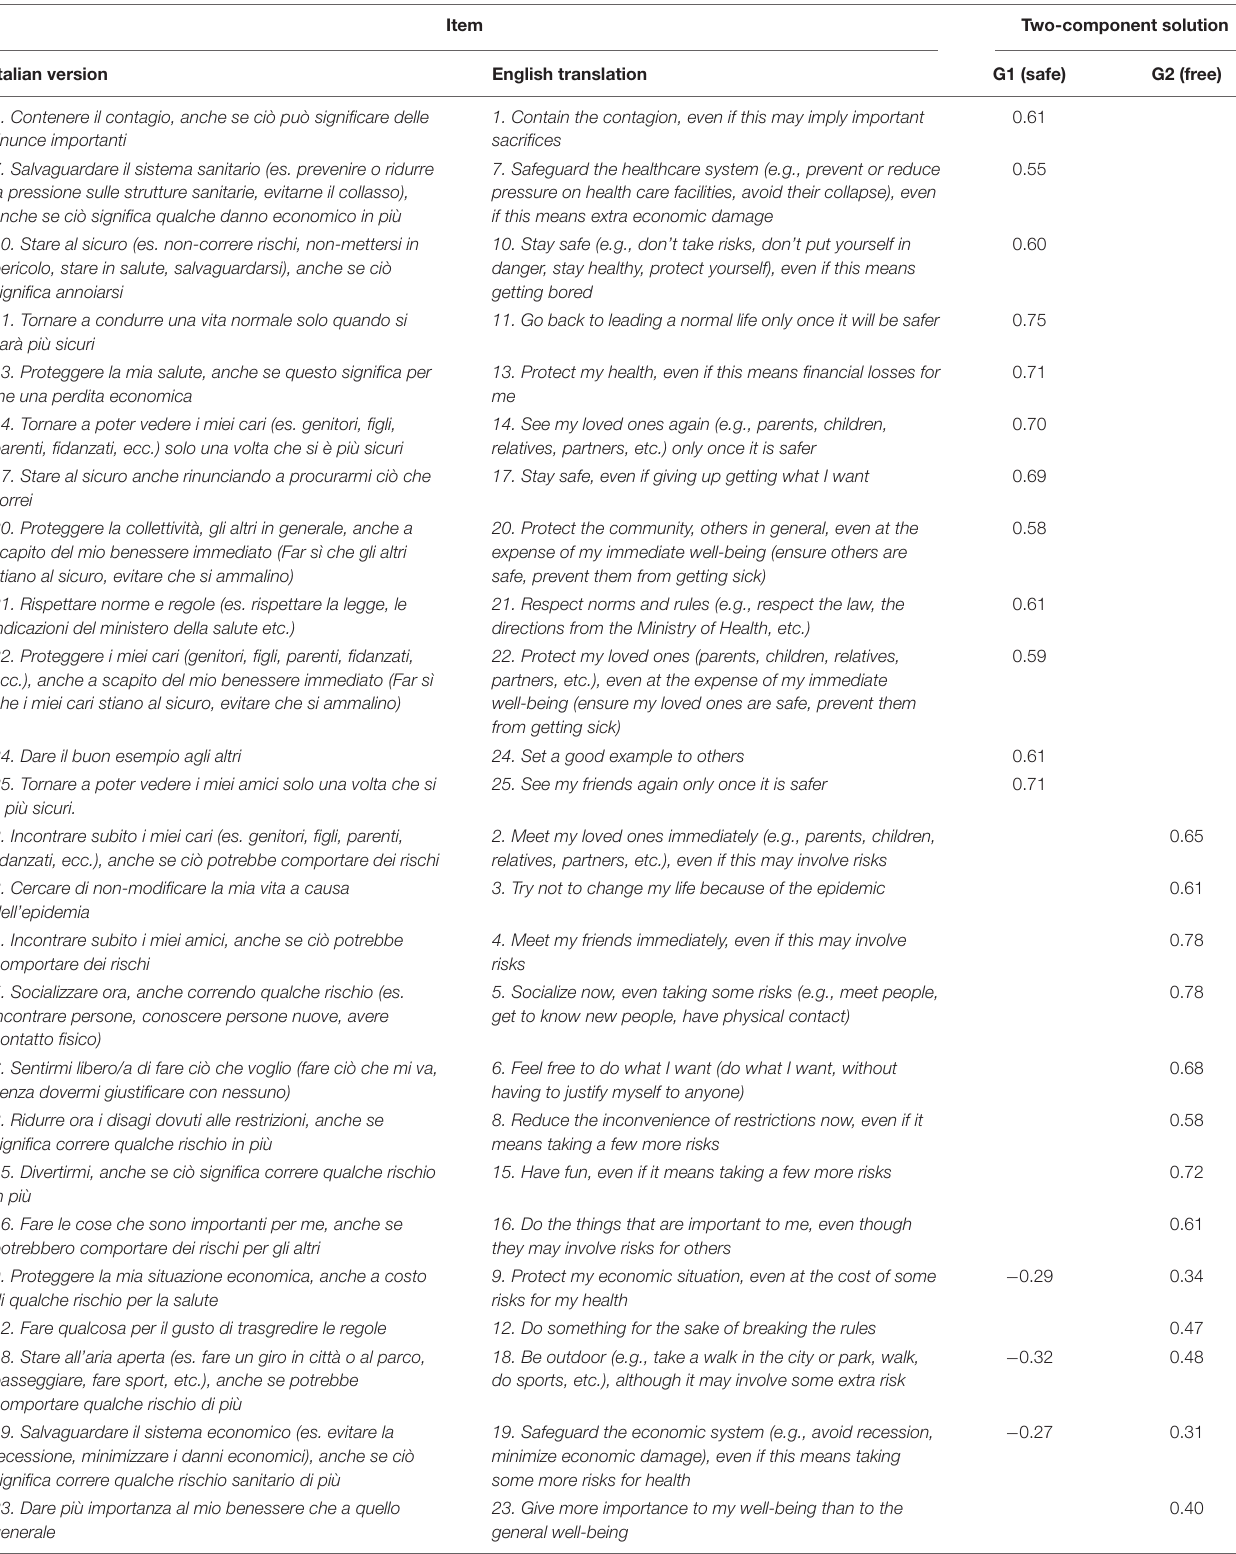
TABLE 3 | PCA loadings for the COVID-19 goal questionnaire.